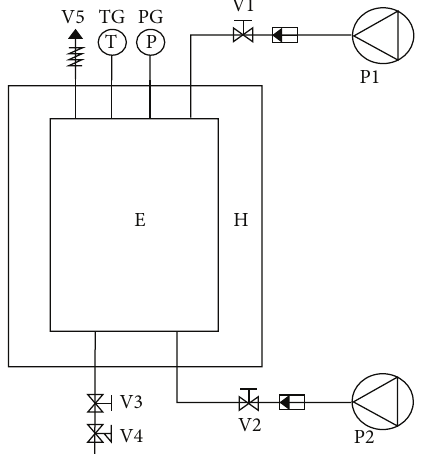
Table 2: Levels of variables in biodiesel production. Figure 1: Schematic diagram of the supercritical reaction system: E, reaction vessel; H, heater and jacket; P1, high-pressure liquid pump; P2, super-critical CO 2 pump; V1 ∼ 3, high-pressure valves; V4, back-pressure valve; V5, release valve; PG, pressure gauge; TG, temperature